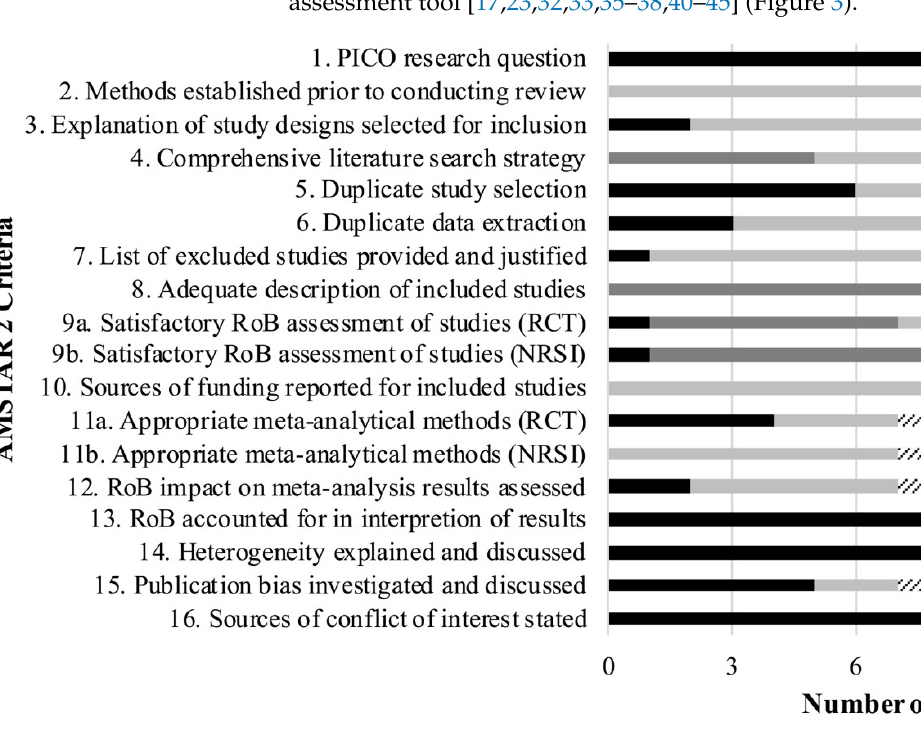
Figure 3. Quality assessment of the reviews using the AMSTAR 2 tool. RCT: randomized control trial; NSRI: non-randomized studies of interventions.